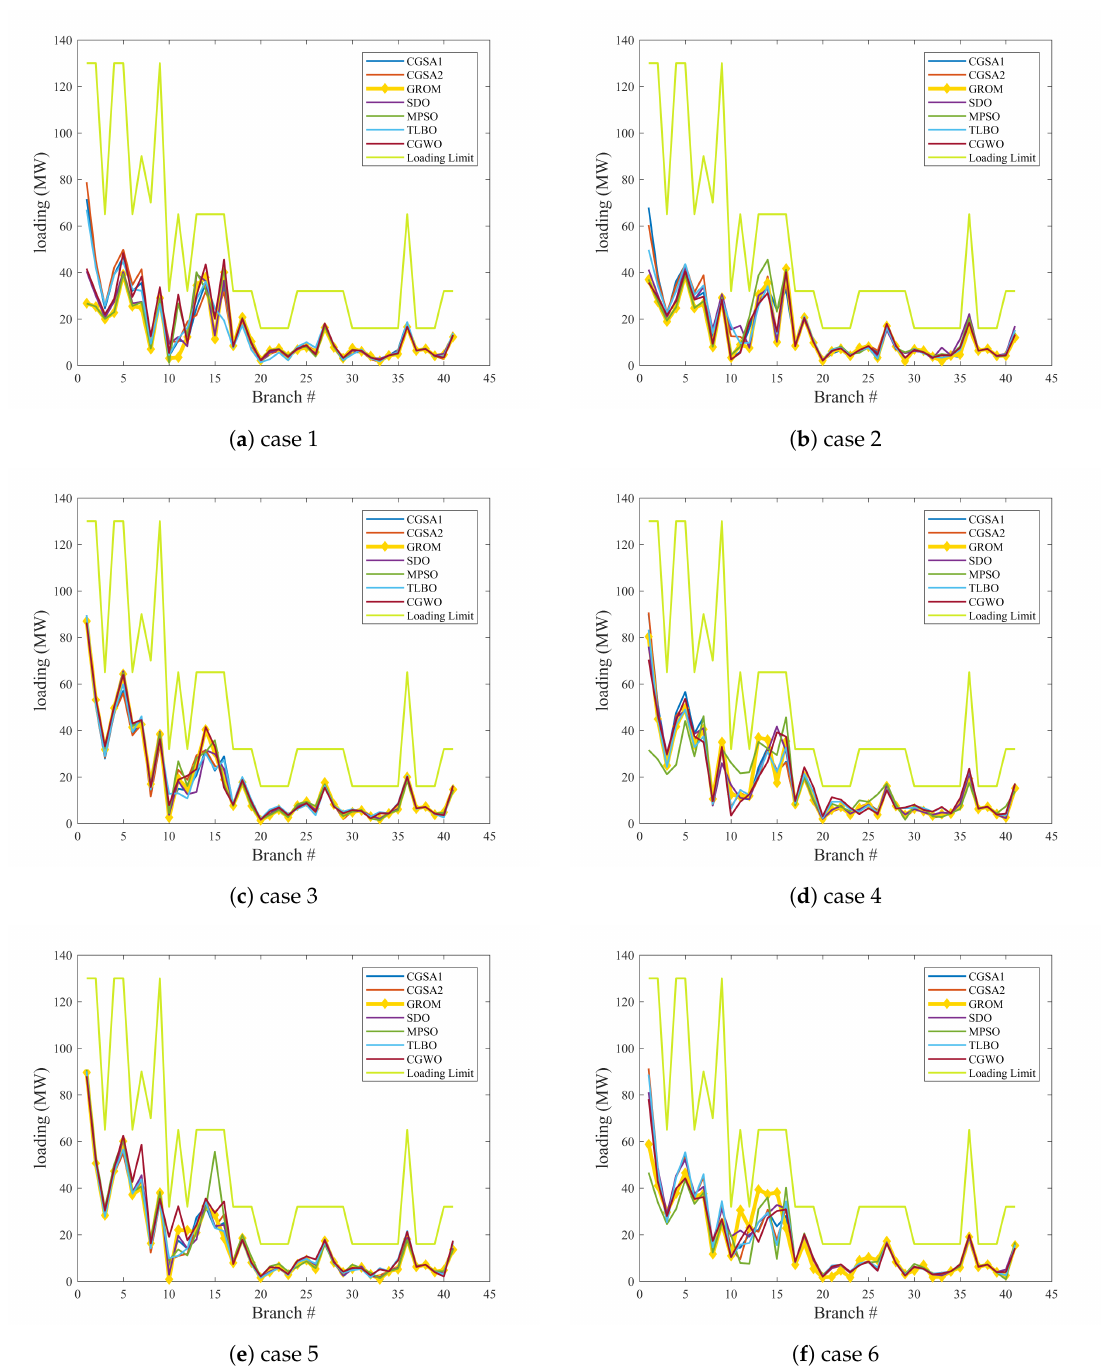
Figure 5. Loading profile for single-objective optimal power